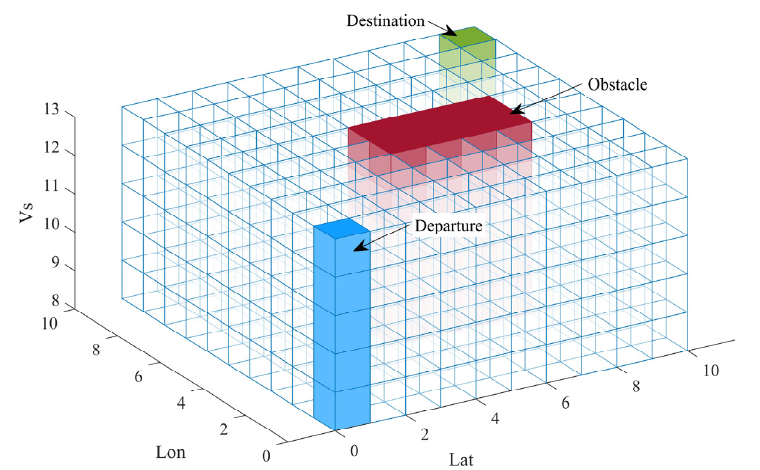
Figure 12. Three-dimensional A* algorithm for speed optimization.